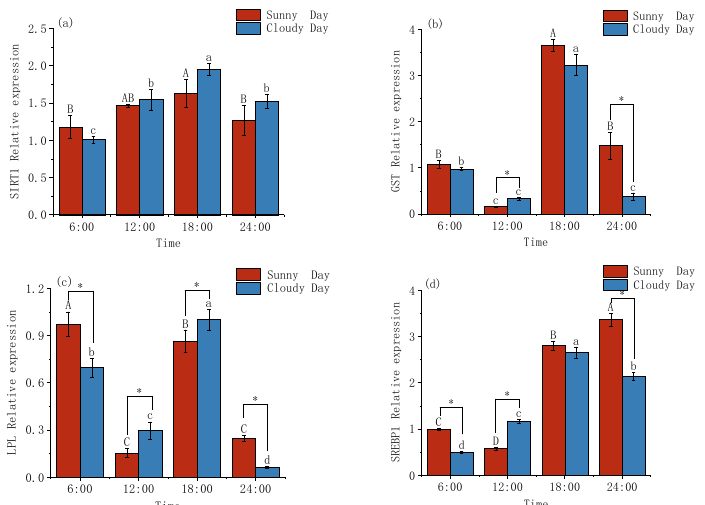
Figure 2. Expression of hepatic metabolic genes during 24 h in different weather in mackerel tuna. ( a ): SIRT1 ; ( b ): GST ; ( c ): LPL ; ( d ): SREBP1 . Red in each graph represents sunny days, and blue represents cloudy days. The presence of different letters indicates significance by ANOVA and Tukey’s tests ( p < 0.05). * represents significant differences at the same time point ( p < 0.05).